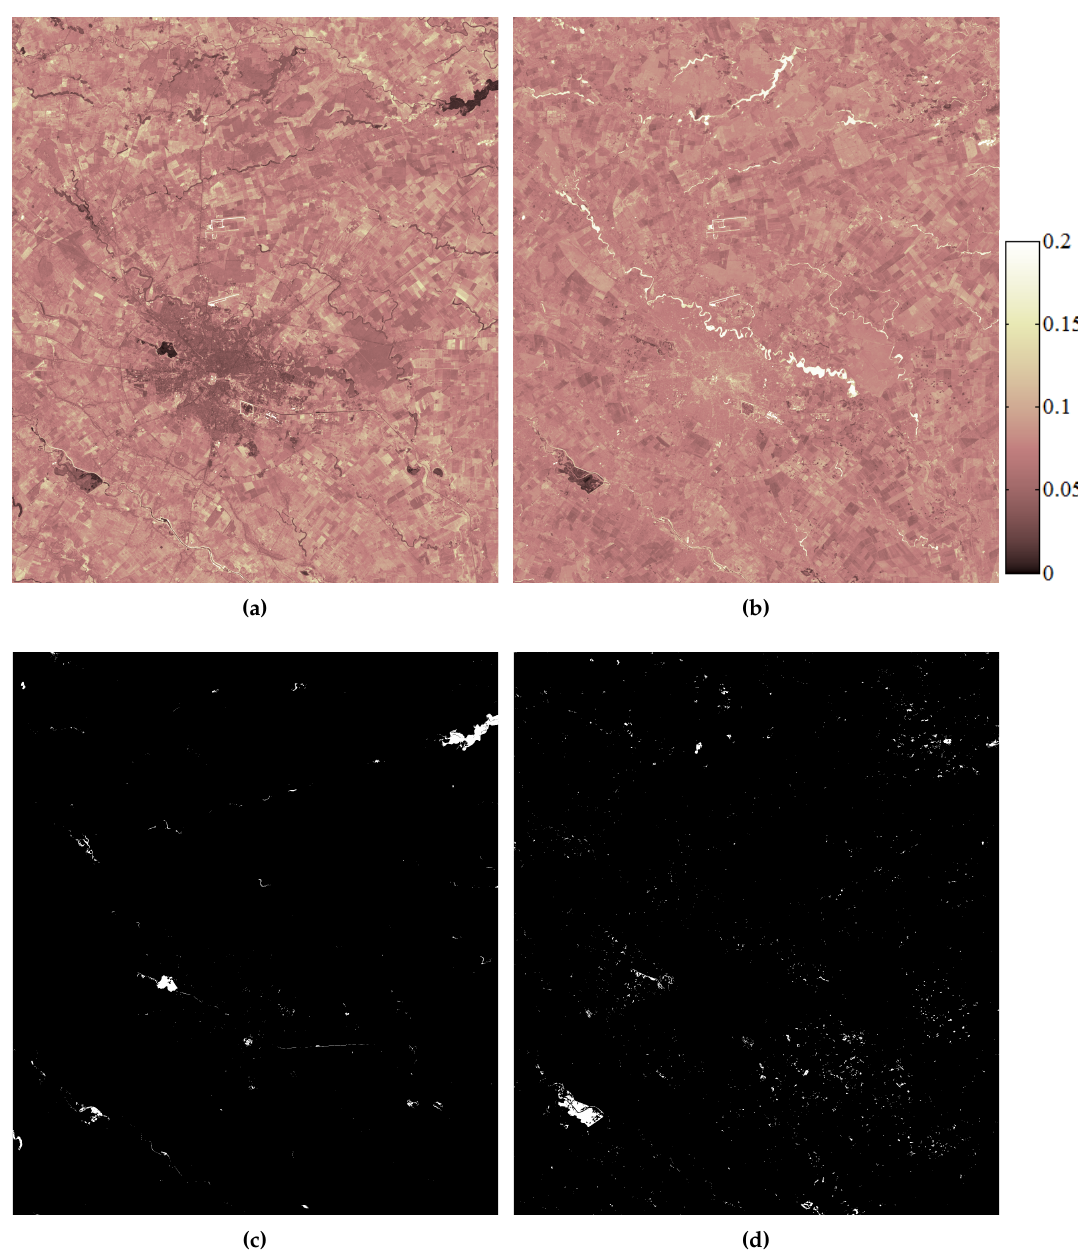
Figure 8. Pattern discovery in short Landsat SITS. ( a ) DTW distance image for a query marked inside the Morii & Dridu accumulation lakes. ( b ) DTW distance image for a query marked inside Mihailesti accumulation lake. ( c ) Pattern discovery using the proposed method for Morii & Dridu accumulation lakes. ( d ) Pattern discovery using the proposed method for Mihailesti accumulation lake. In the case of DTW distance images presented in ( a , b ), dark color represents similar evolutions and bright color represents non-similar evolutions, whereas in ( c , d ), white pixels correspond to spatio-temporal patterns that are similar to the query, which was selected from the region of